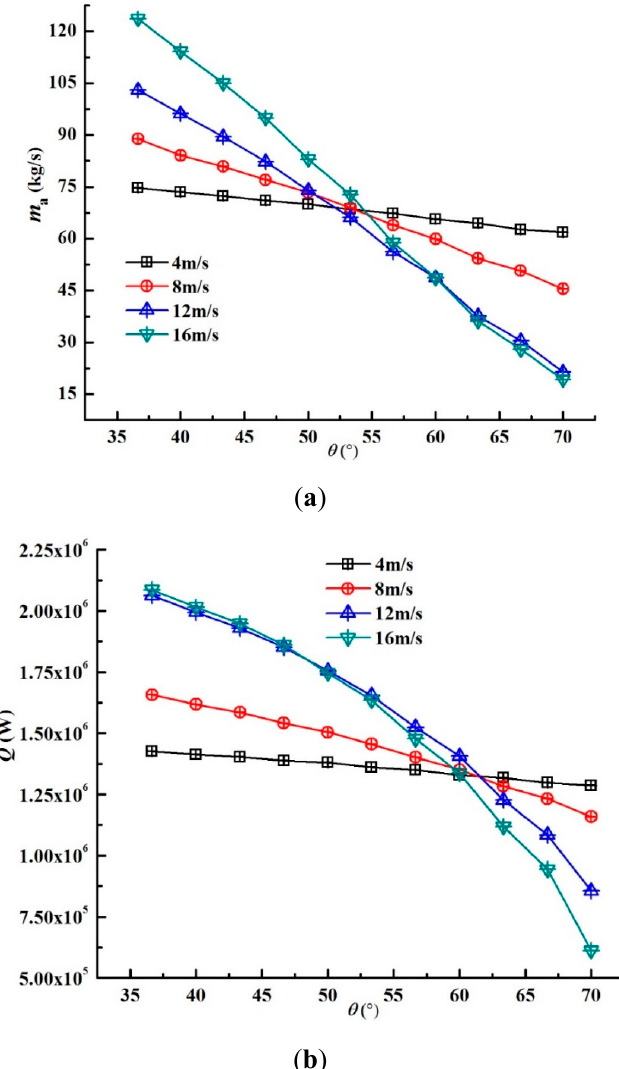
Figure 11. Thermo-flow performances of the middle-front deltas. ( a ) Air mass flow rate, ( b ) heat